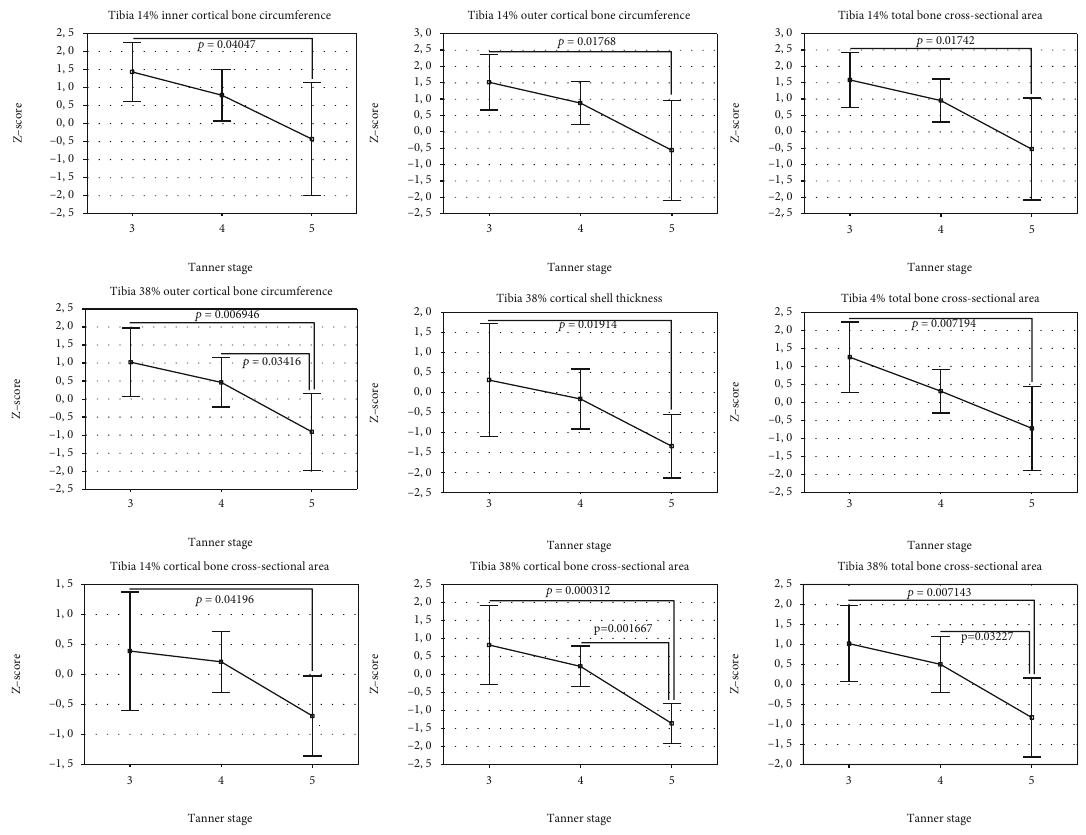
Figure 3: Lower leg Z -scores for selected cross-sectional bone dimensions in boys by Tanner stage (mean and 95% CI).